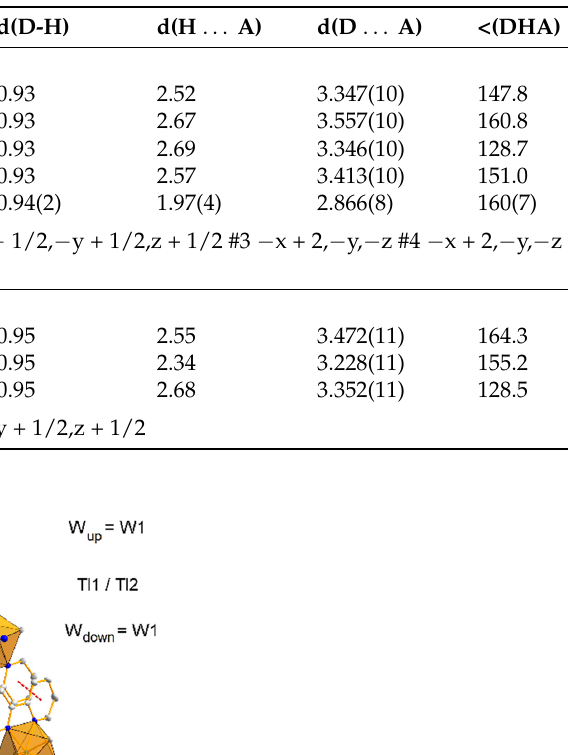
Table 2. Hydrogen bonds for 1 and 2 [Å and ◦ ].